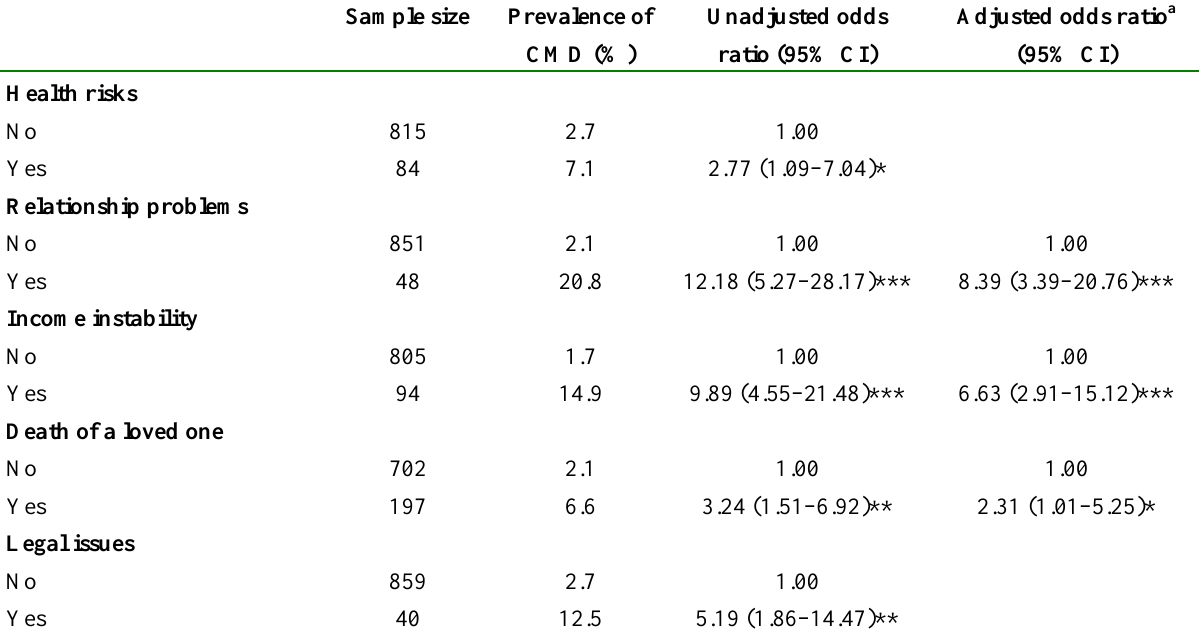
Table 4. Odds ratios for different categories of life events and mental